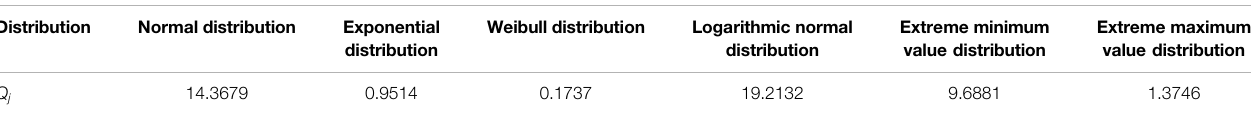
TABLE 6 | The life distribution deduction